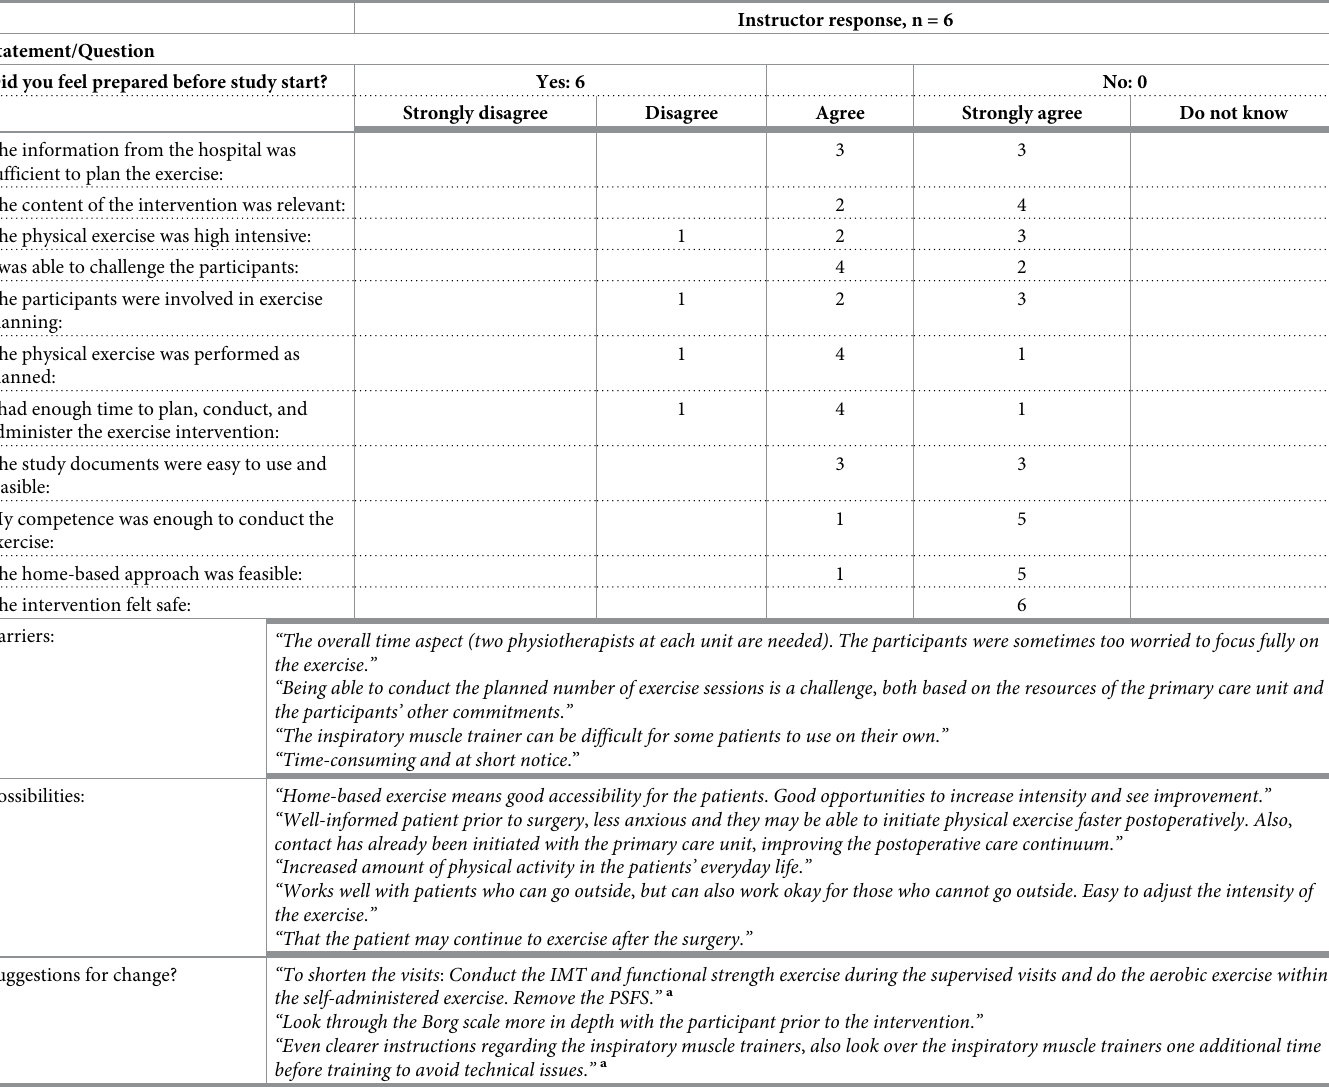
Table 3. Instructor satisfaction with the exercise